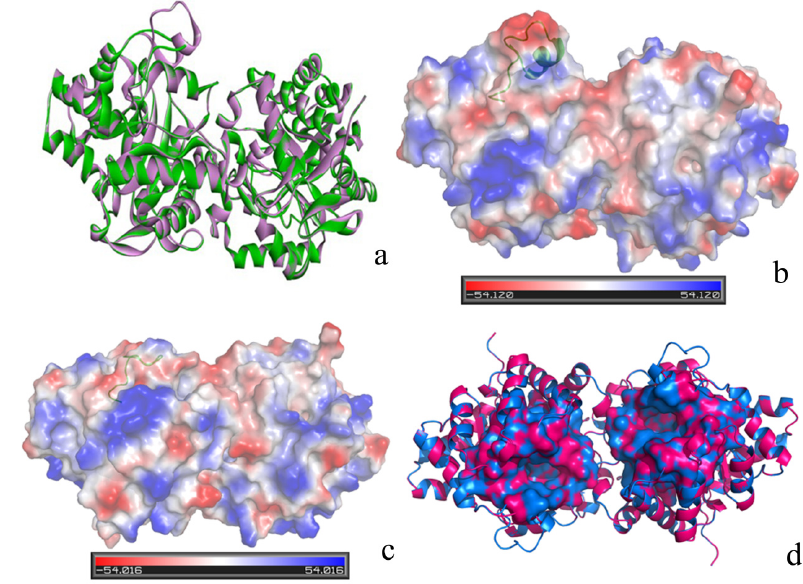
Figure 2. ( a ) The 3D structure alignment between the loop 7-2-H254R (green) and the WT PTE (purple); ( b ) The protein contact potential of the WT PTE generated with Pymol; ( c ) The protein contact potential of the loop 7-2-H254R variant; ( d ) The binding pocket between between the loop 7/H254R (purple) and the WT PTE (blue).